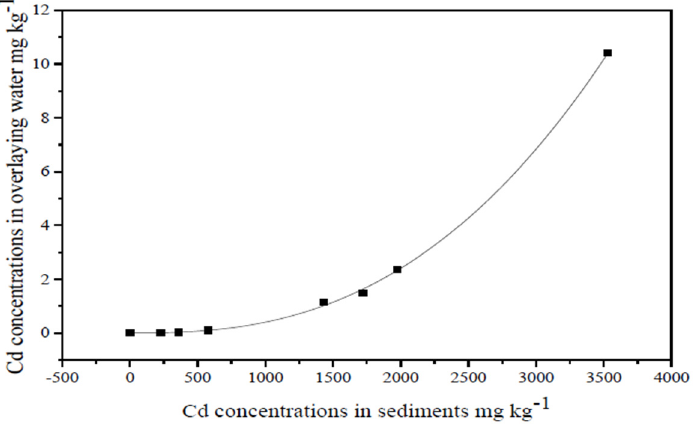
Figure 2. Cadmium concentrations in simulated sediments and overlying water systems (curve fitted by the power function).